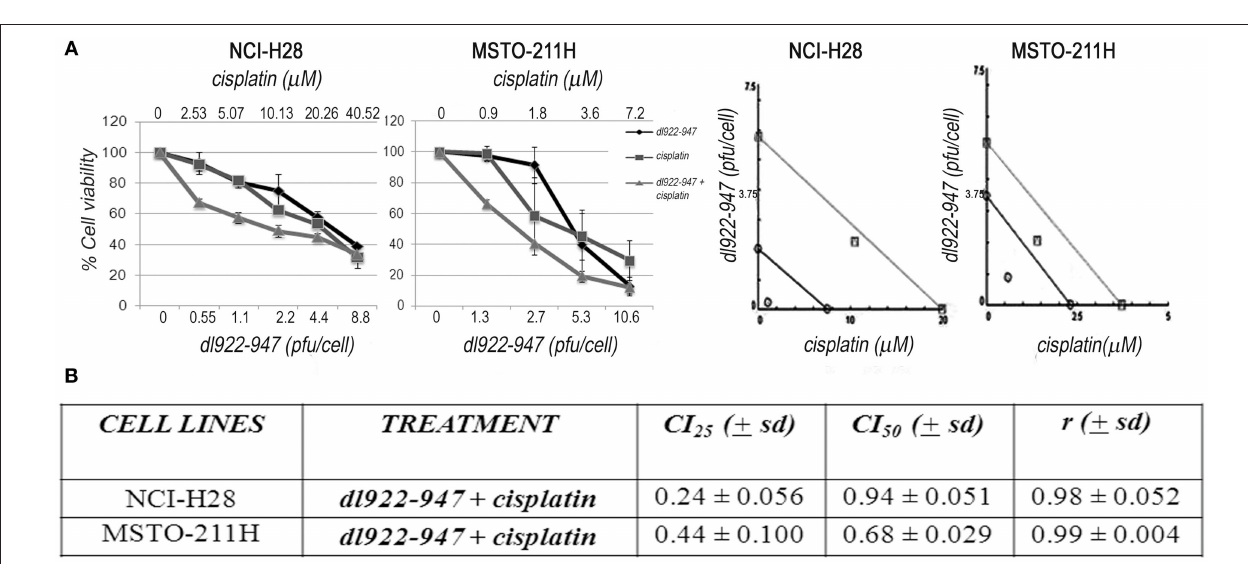
FIGURE 8 | Synergistic effect of the dl 922-947 and cisplatin combination. (A) MSTO-211H and NCI-H28 cell viability was analyzed by SRB assay 5 days after treatment with dl 922-947, both alone and in combination with cisplatin. Left: Dose—response curves for dl 922-947 alone, cisplatin alone and their combination. Results represent the means and standard deviations of two independent experiments, each conducted in triplicate, and are expressed as percentages of cell viability, calculated with respect to the control cells treated with DMSO alone. Right: Isobologram analysis to assess drug synergism. Isobolograms are derived from the mean values of the dose—response experiments reported in the left, through the CompuSyn software 1.0 at an effect level of 25 and 50%. Data points on the line indicate additivity; points below the line indicate synergy; points above the line indicate antagonism. (B) The table reports the means ± s.d. of the drug combination index (CI) at 25% (CI25) and 50% (CI50) of cell killing after 5 days of treatment and the r -values. CI values below 1 indicate drug